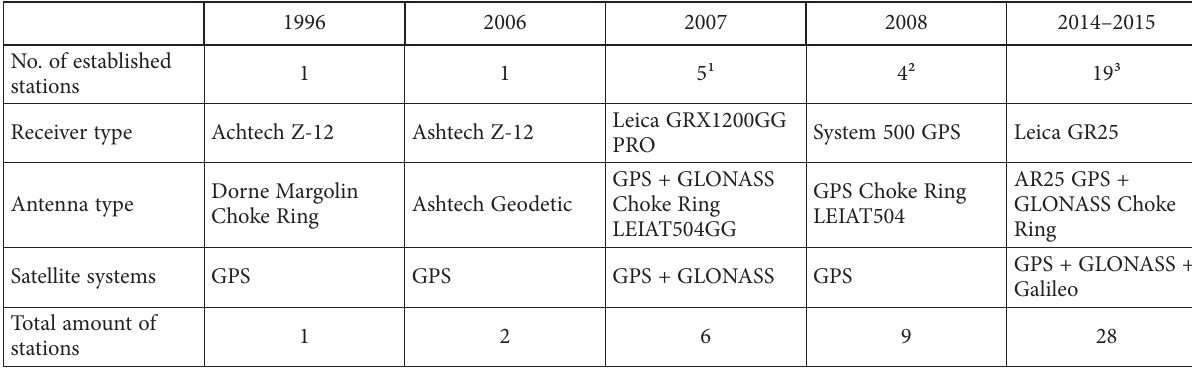
Table 1. Overview of equipment changes in ESTPOS network